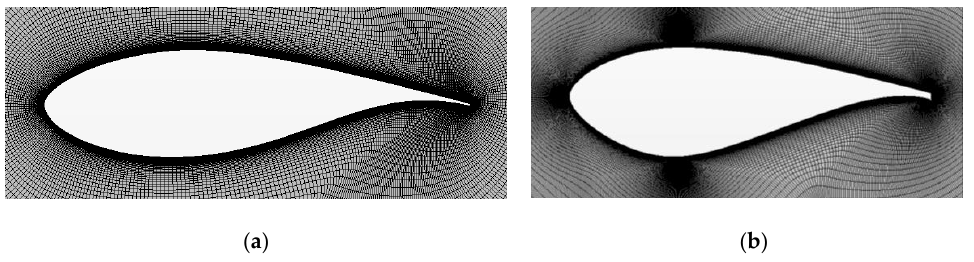
Figure 2. Enlarged views of the two-dimensional meshes on the airfoils: ( a ) DU91W250 airfoil; ( b ) DU97W300 airfoil.